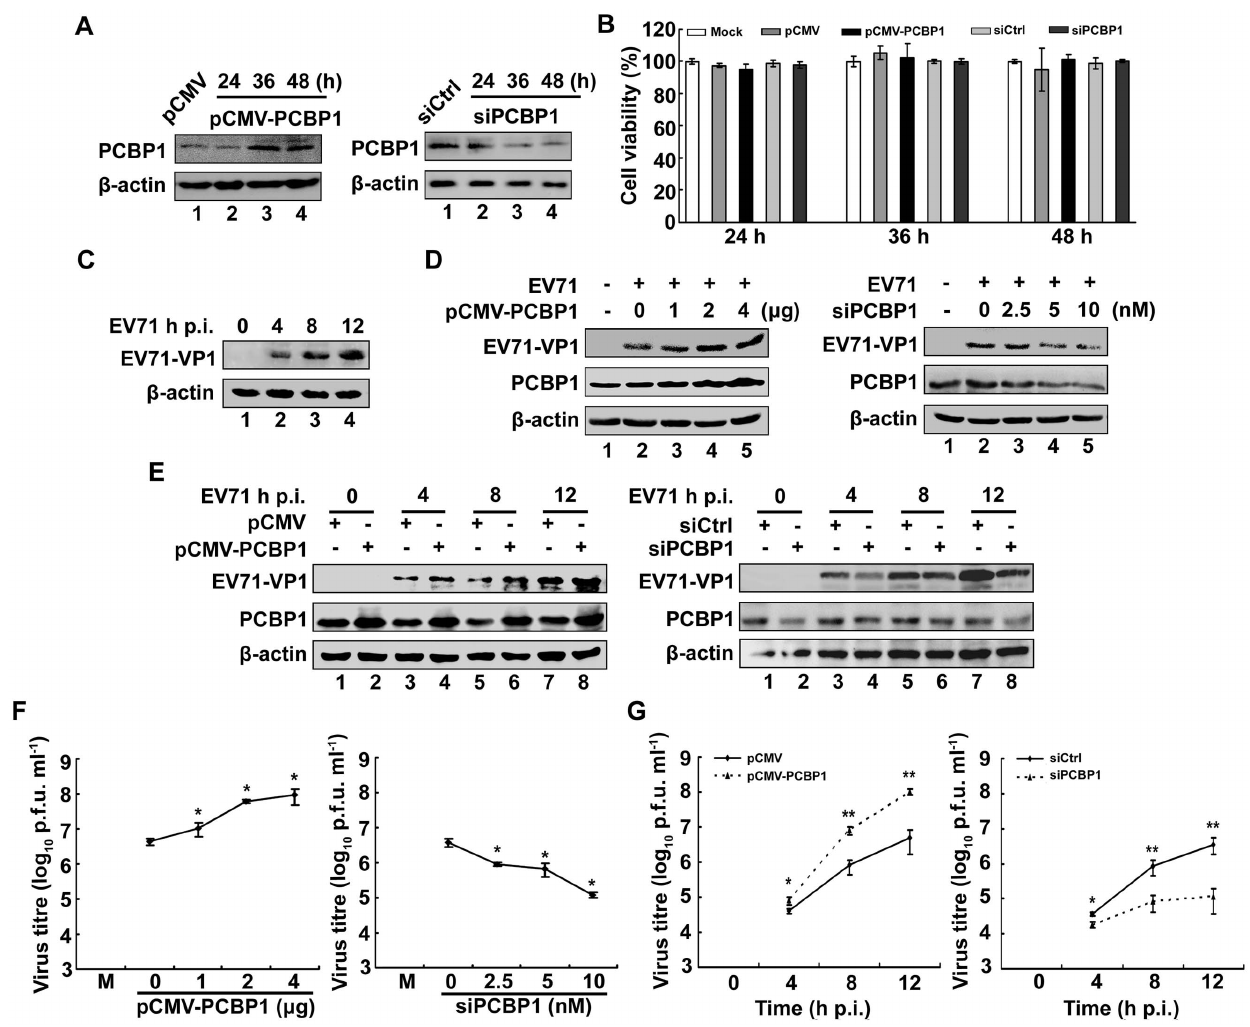
Figure 6. Analysis of PCBP1 in the regulation of EV71 viral protein expression and virus production. (A) RD cells were transfected with pCMV-PCBP1 (to over-express PCBP1), pCMV (a negative control of pCMV-PCBP1), siPCBP1 (to knock-down PCBP1) and siCtrl (a negative control of siPCBP1), respectively. At 24, 36, and 48 h post-transfection, cells extracts were prepared and proteins were detected by western blot using mouse anti-PCBP1 antibody or mouse anti- b -actin antibody. (B) RD cells were transfected with pCMV-PCBP1, pCMV, siPCBP1, and siCrtl, respectively. At 24, 36, and 48 h post-transfection, viability of transfected cells were determined by MTT assay. The viability of mock cells was normalized to 100%. Data are from three independent experiments with similar results. (C) RD cells were infected with or without EV71 at an MOI of 5 for 4, 8, and 12 h. Mock- infected and EV71-infected cells were lysed and proteins were detected by western blot analysis using antibodies to EV71 VP1 protein or b -actin protein. (D) RD cells were transfected with pCMV-PCBP1 at different concentrations (0, 1, 2, and 4 m g) or with pCMV at different concentrations (4, 3, 2, and 0 m g), siPCBP1 at different concentrations (0, 2.5, 5, 10 nM) or with siCtrl at different concentrations (10, 7.5, 5, 0 nM), respectively, for 36 h, and then infected with or without EV71 at an MOI of 5 for 12 h. Mock-infected and EV71-infected cells were lysed and proteins were detected by western blot analysis using antibodies to EV71 VP1 protein, PCBP1 or b -actin protein. (E) RD cells were transfected with pCMV-PCBP1, pCMV, siPCBP1, and siCtrl, respectively, for 36 h, and then infected with EV71 at an MOI of 5 for 4, 8, and 12 h. EV71-infected cells were lysed and proteins were detected by western blot analysis using antibodies to EV71 VP1 protein, PCBP1 or b -actin protein. (F) Cell culture supernatants from (D) were prepared and subjected to plaque assays and viral infectivity titers of culture supernatants (plaque forming units per ml, PFU/ml) on EV71-infected RD cells were determined. (G) Cell culture supernatants from (E) were collected and viral infectivity titers in supernatants were determined. Viral infectivity titers are expressed as means 6 S.E. (n=3) of three independent experiments (**, p , 0.01; *, p , 0.05).